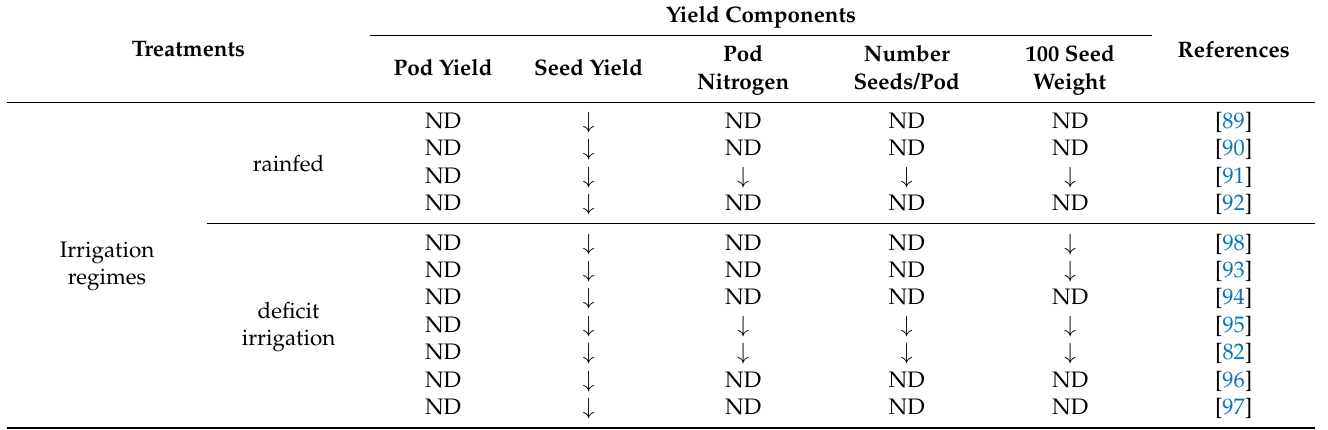
Table 3. A summary of the impact on common bean yield of varying irrigation regimes and intervals applied to different crop life history stages. The ND denotes nondefined. The ↓ denotes the decrease in crop yield and the ↑ denotes the increase in crop